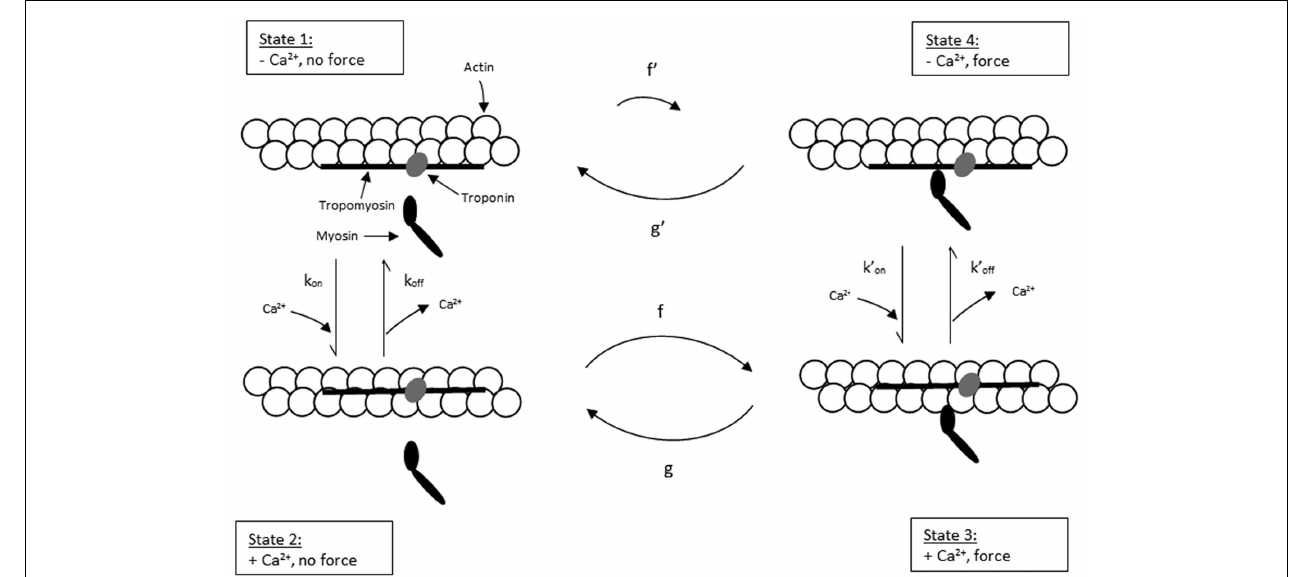
blocked state. Strong crossbridge formation and dissociation from thin FIGURE 1 | Schematic diagram of four-state model. On the left hand side filaments are governed by rate constants f and g , respectively. g (cid:2) Describes are states where myosin forms weak, non-force-producing crossbridges. On the right hand side are force generating states where myosin binds strongly the rate of crossbridge detachment from regulatory units without Ca 2 + , as to actin.The upper states represent Ca 2 + free states whereas the lower may occur during relaxation of skeletal muscle; the rate of strong crossbridge formation ( f (cid:2) ) is practically non-existent in this condition. State 4 (upper right) states represent Ca 2 + bound. Ca 2 + binds toTnC and activates regulatory units is needed to model P – k TR relationships in skeletal muscle, but can be omitted with rate constants k on (left) and k (cid:2) (right), while k off (left) and k (cid:2) (right) reflect on off the kinetics of processes associated with regulatory units returning to the when modeling cardiac muscle (Hancock et al.,